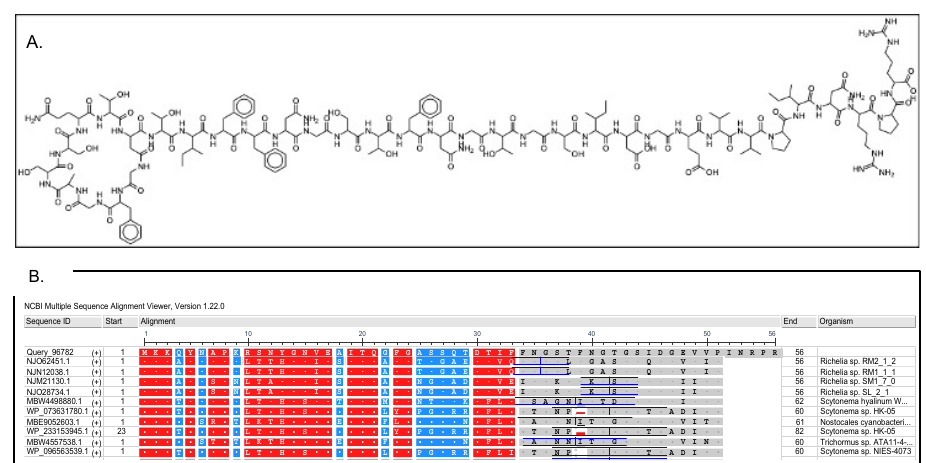
Figure 3. Characterization of the lasso peptides from the reconstructed genome of the Cyanocohniella sp. LLY cyanobacterium. ( A ) Primary chemical structure of the cleaved Lasso P, made of 36 residues. ( B ) Protein sequence alignment of Lasso P peptide against NCBI non-redundant database.